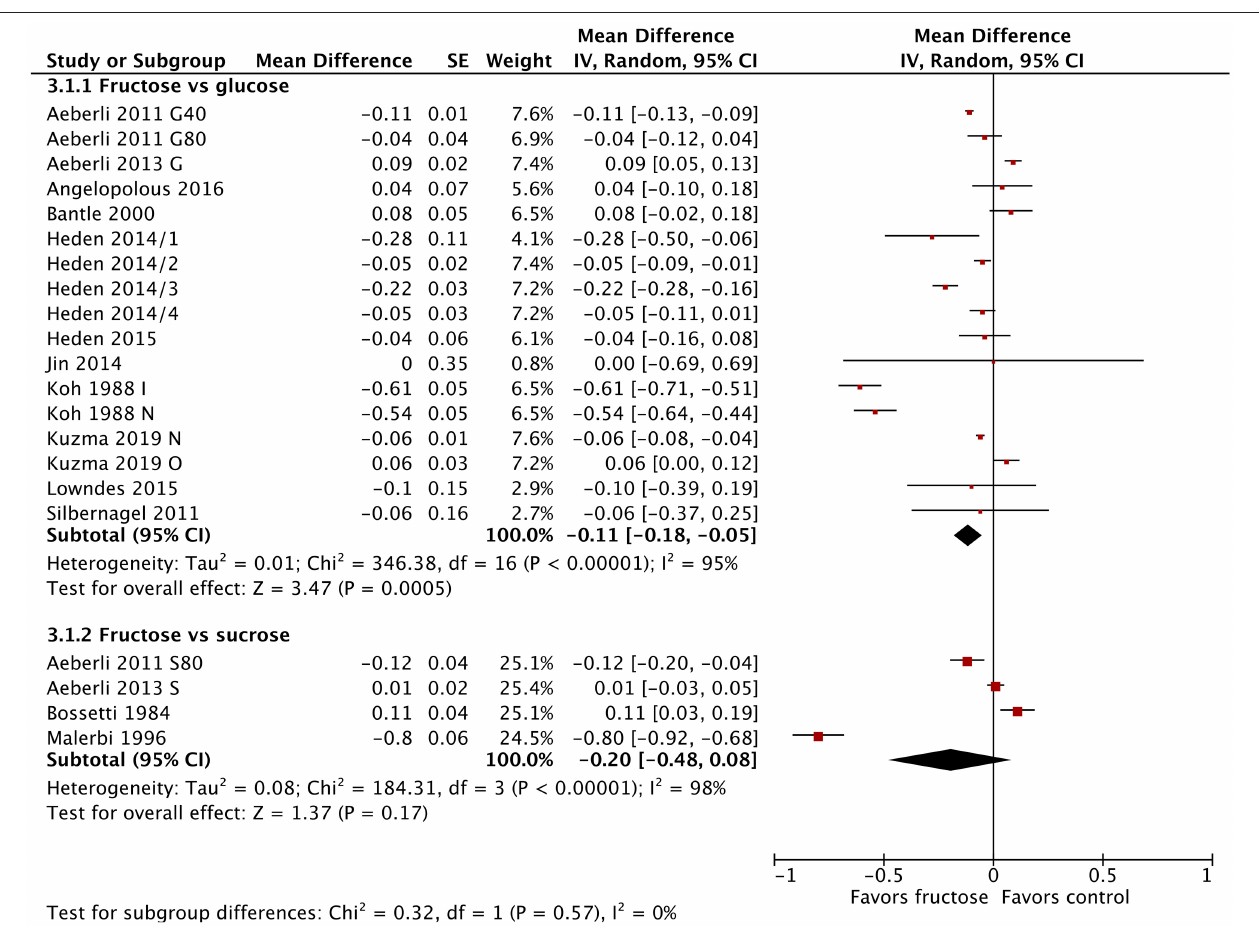
FIGURE 2 | Subgroup meta-analysis of fasting blood glucose following isoenergetic substitution of glucose or sucrose by fructose in food or beverages by substituted sugar. Values are mean differences (95% CIs) (expressed as mmol/L) between fasting blood glucose after fructose consumption and fasting blood glucose following glucose or sucrose consumption. IV, inverse variance; SE, standard error; G40, fructose/glucose 40 g/day; G80, fructose/glucose 80 g/day; G, glucose; S, sucrose; I, impaired glucose tolerance, N, normal glucose tolerance/body weight; O, overweight.